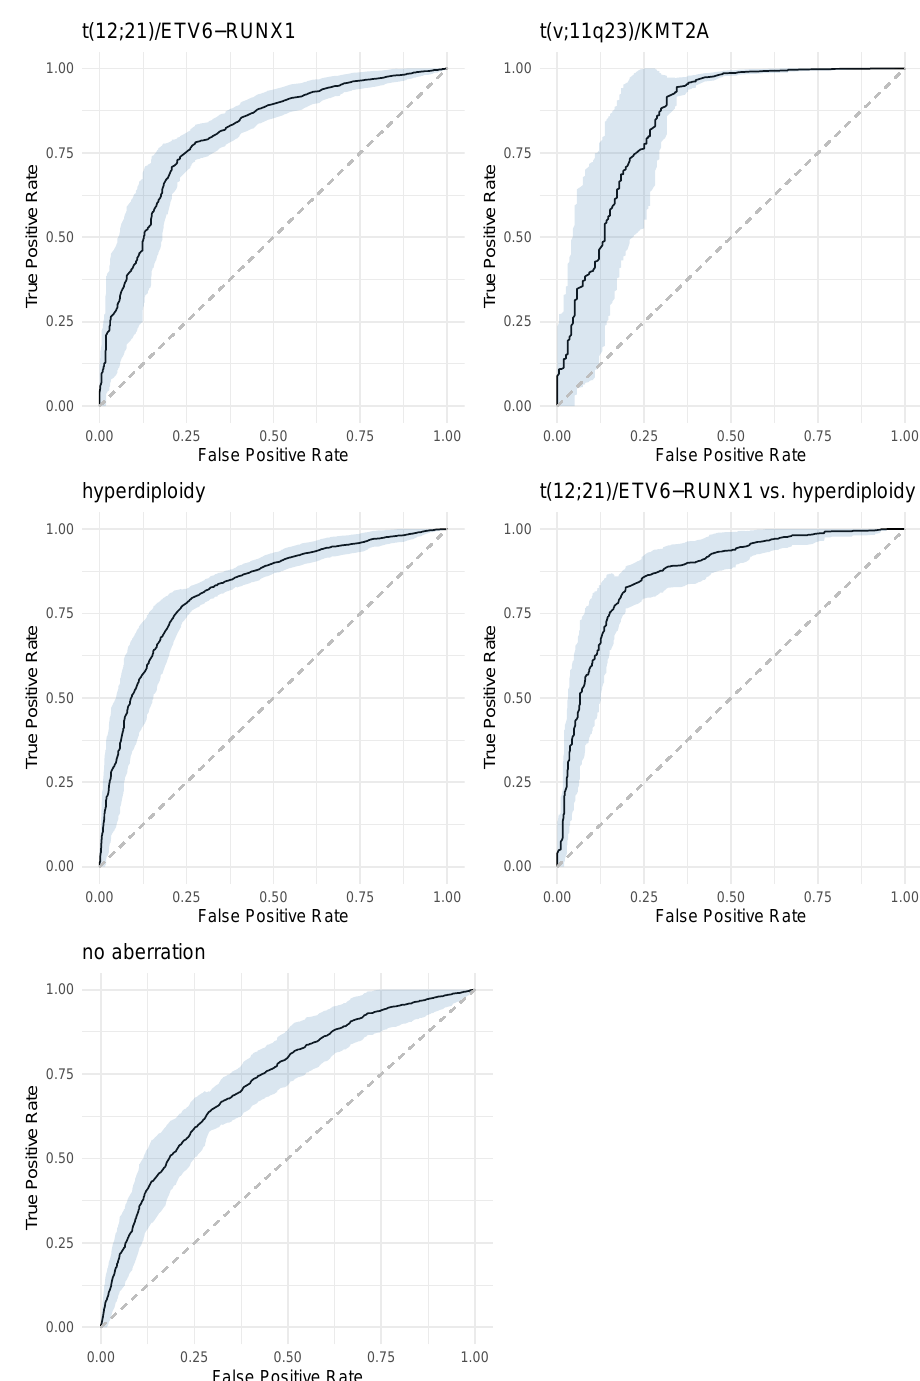
Figure 4. Receiver operating characteristic analysis for t(12;21)/ETV6-RUNX1 and t(x;11q23)/KMT2A